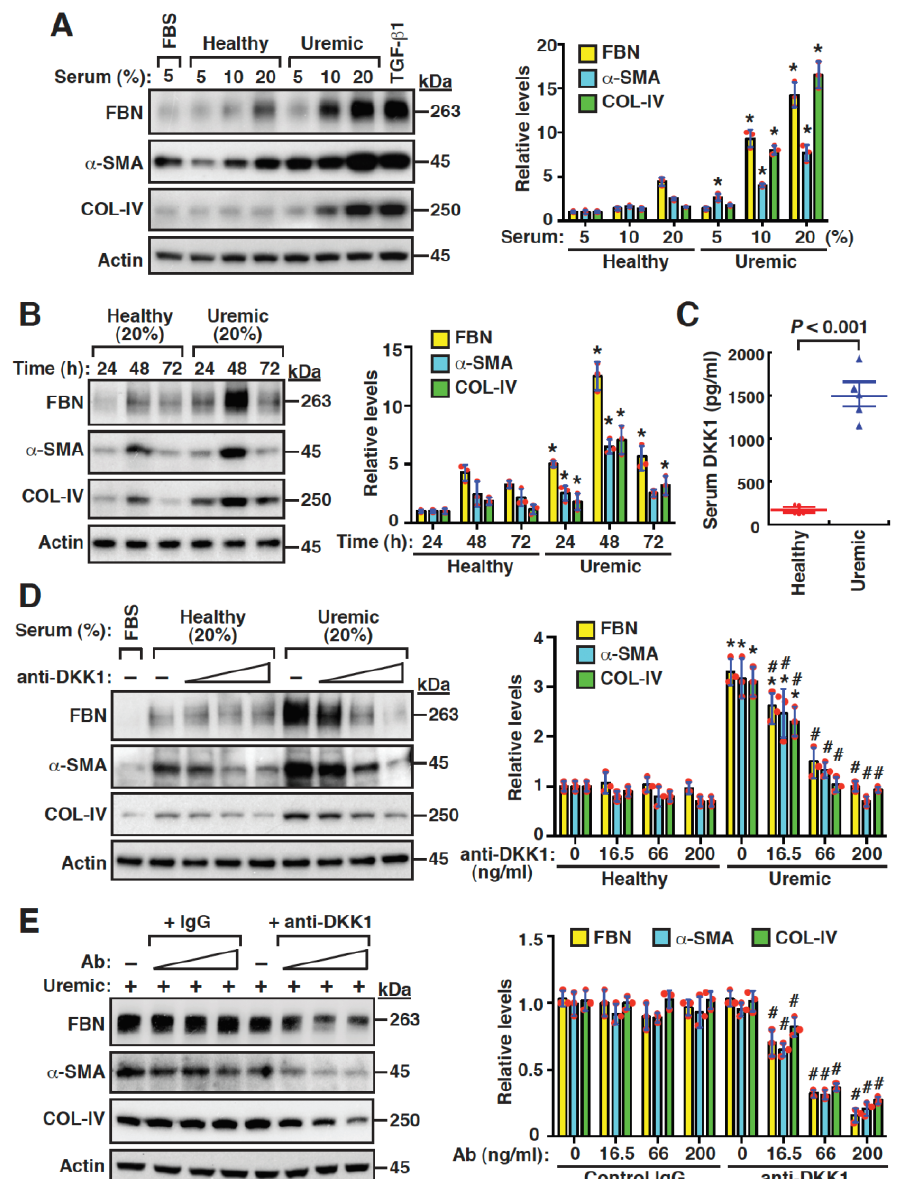
Figure 5. Uremic serum promotes fibrogenesis of renal mesangial cells through the DKK1-mediated signaling pathway. ( A ) Western blot analysis of fibronectin (FBN), α -smooth muscle actin ( α -SMA), and collagen IV (COL-IV) expressed in mouse mesangial cells that were cultured in media with increasing concentrations (5, 10 and 20%) of healthy control serum or uremic serum. The healthy serum and uremic serum samples were pooled at equal volumes from blood samples of five healthy control subjects and five uremic patients, respectively. Quantitative data from Western blots are plotted as mean ± SD (n = 3). * p < 0.05 versus the healthy controls at the corresponding serum concentrations. ( B ) Western blot analysis of FBN, α -SMA and COL-IV expressed in mouse mesangial cells cultured in media with 20% healthy control serum or uremic serum for 24, 48 and 72 h. Quantitative data from Western blots are plotted as mean SD (n = 3). * p < 0.05 versus the healthy controls at the corresponding time points. ( C ) Serum DKK1 levels of five healthy control subjects and five uremic patients included in the in vitro experiments. ( D ) Effects of increasing amounts of anti-DKK1 neutralizing antibody (16.5, 66 and 200 ng/mL) on the expression of FBN, α -SMA and COL-IV in mesangial cells cultured in media with 20% healthy control serum or uremic serum. Quantitative data from Western blots are plotted as mean SD (n = 3). * p < 0.05 versus the healthy controls, # p < 0.05 versus the untreated uremic serum group. ( E ) Effects of increasing amounts of an IgG control and anti-DKK1 antibody on the expression of profibrotic proteins in mesangial cells